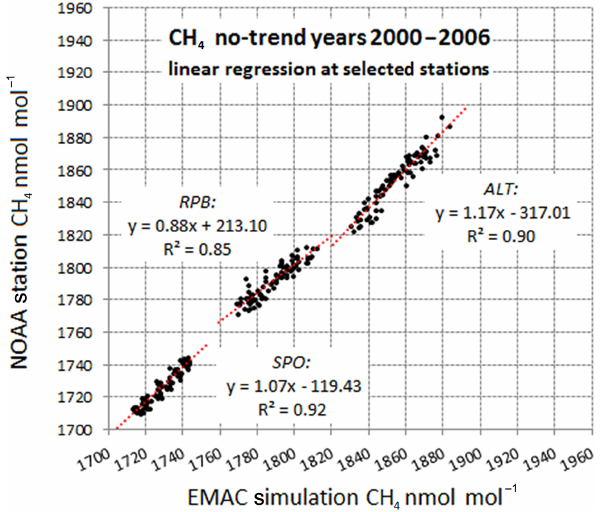
Figure 4. Regression analysis of EMAC calculations vs. observa- tions of CH 4 at NOAA stations ALT, RPB, and SPO for no-trend years